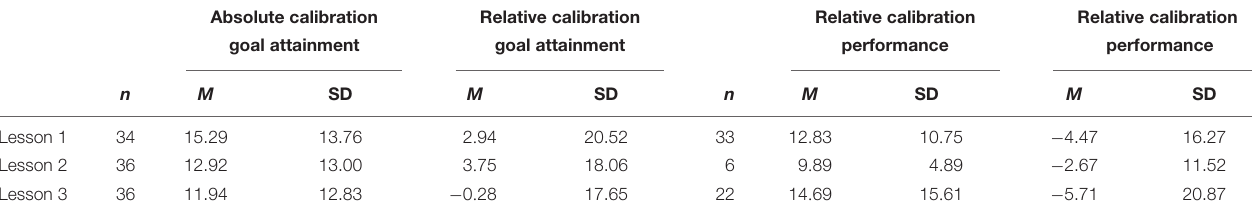
TABLE 6 | Signals for regulation : overview of absolute and relative calibration of goal attainment and performance per lesson.